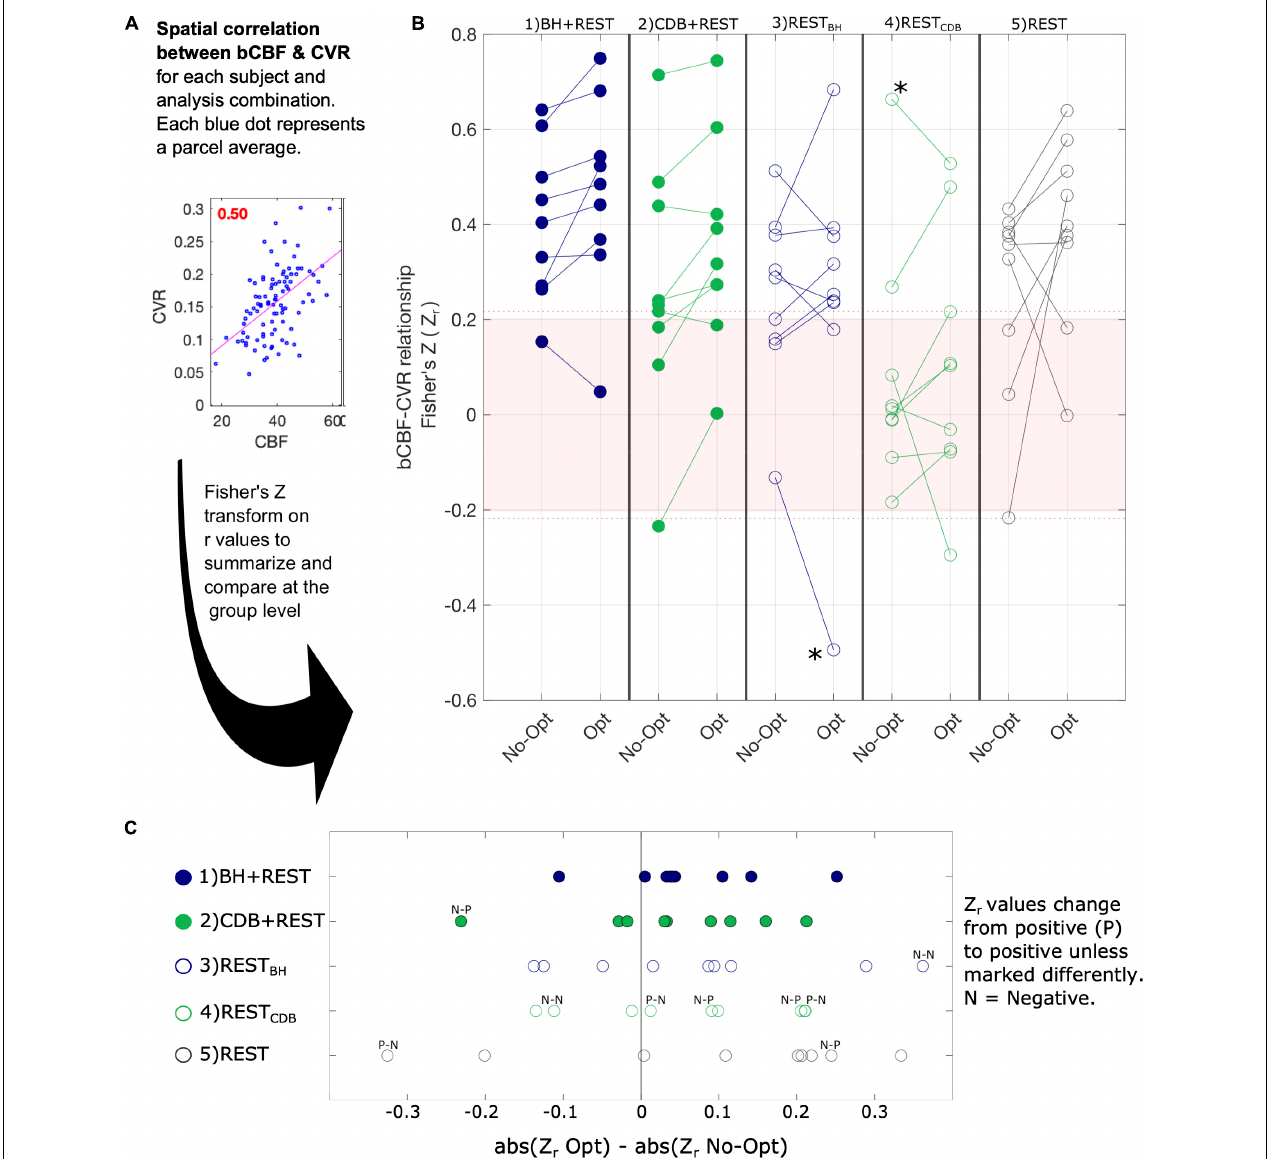
FIGURE 4 | The association between bCBF and CVR values in 96 cortical parcels was computed for each subject and analysis combination (panel A ). A Fisher’s Z transformation is applied to the correlation values to allow group statistical testing; panel (B) visualizes these transformed correlations for the five segments (columns), both for CVR values with no lag optimization (No-Opt) and CVR values with lag optimization (Opt). The shaded pink box in panel B represents correlations that were not significant at the single-subject level, based on 96 datapoints and a critical value of 1.96 ( p < 0.05, two-tailed). When generating these correlation values for each subject, outlier parcels (based on Cook’s distance) were not included. The number of parcels removed from each correlation analysis averaged 5.3 out of 96 (see Supplementary Table 3 ). As removing parcels reduces the degrees of freedom, the dotted pink line shows the adjusted critical value (maximum across participants and data segments shown for reference). Panel (C) shows the change in absolute correlation strength due to lag optimization of the CVR